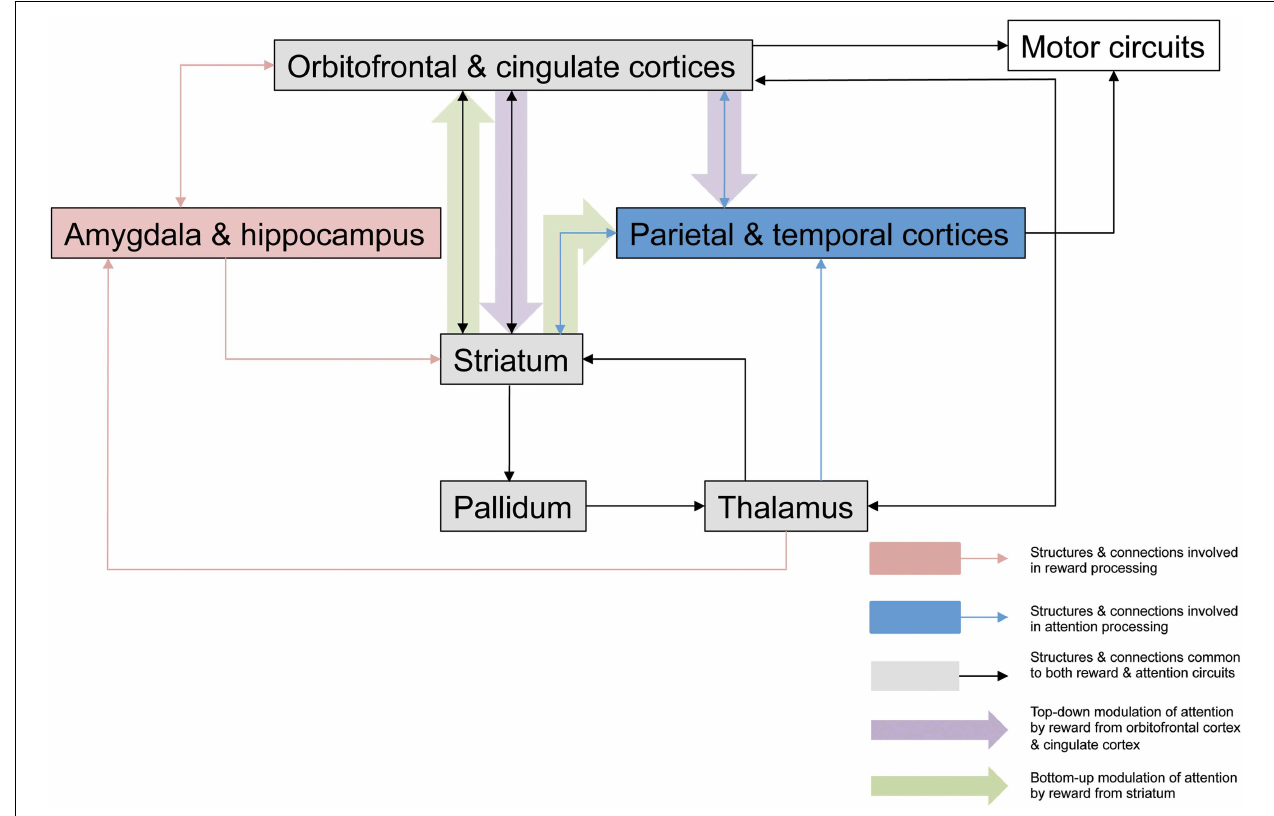
FIGURE 1 | Potential neuroanatomical pathways for motivation- attention interplay .This outlines possible pathways involved in the interaction between motivation and attention that are critical for the actions of reward on spatial neglect. Mesulam (1999) proposed a large scale neurocognitive network with cortical foci in parietal cortex and cingulate cortex that is responsible for attention, and its organization allows very rapid surveys of perceptual representations, multiple coordinate systems, motor strategies, and motivational salience. Striatal neurons have been shown to be critical in reward processing (Haber and Knutson, 2010; Harsay et al., 2011), and striatal dopamine release in response to anticipated reward or amygdala activation secondary to emotionally relevant stimuli may have a direct modulatory effect on attentional signals being relayed to cortical